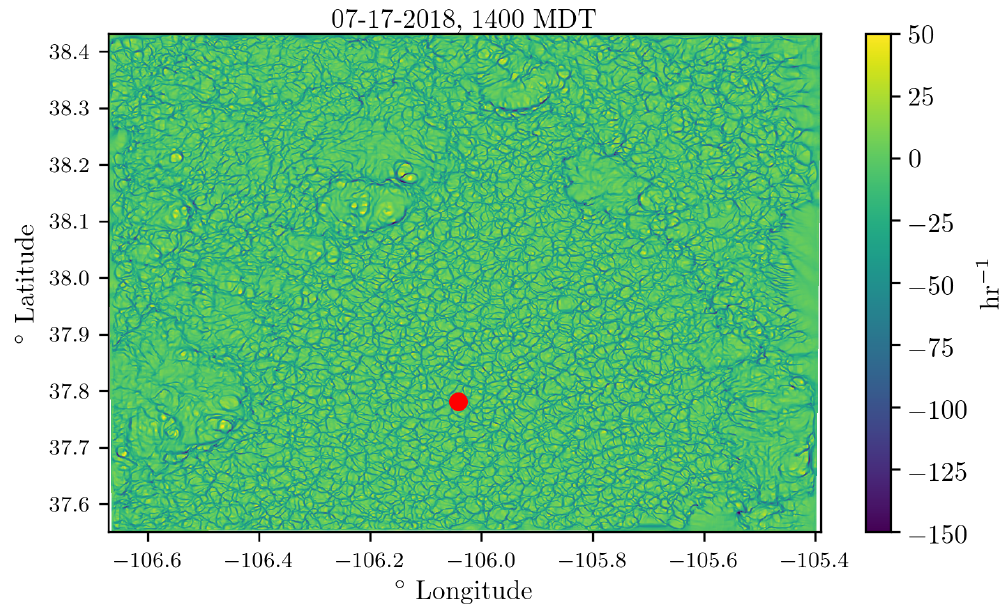
Figure 13. The attraction rate field at 1400 MDT, convective cells can be seen, bordered by troughs of the attracting field, throughout the domain. A front appears to be blowing an attracting feature out of the east of the domain. Sampling region is marked with a red